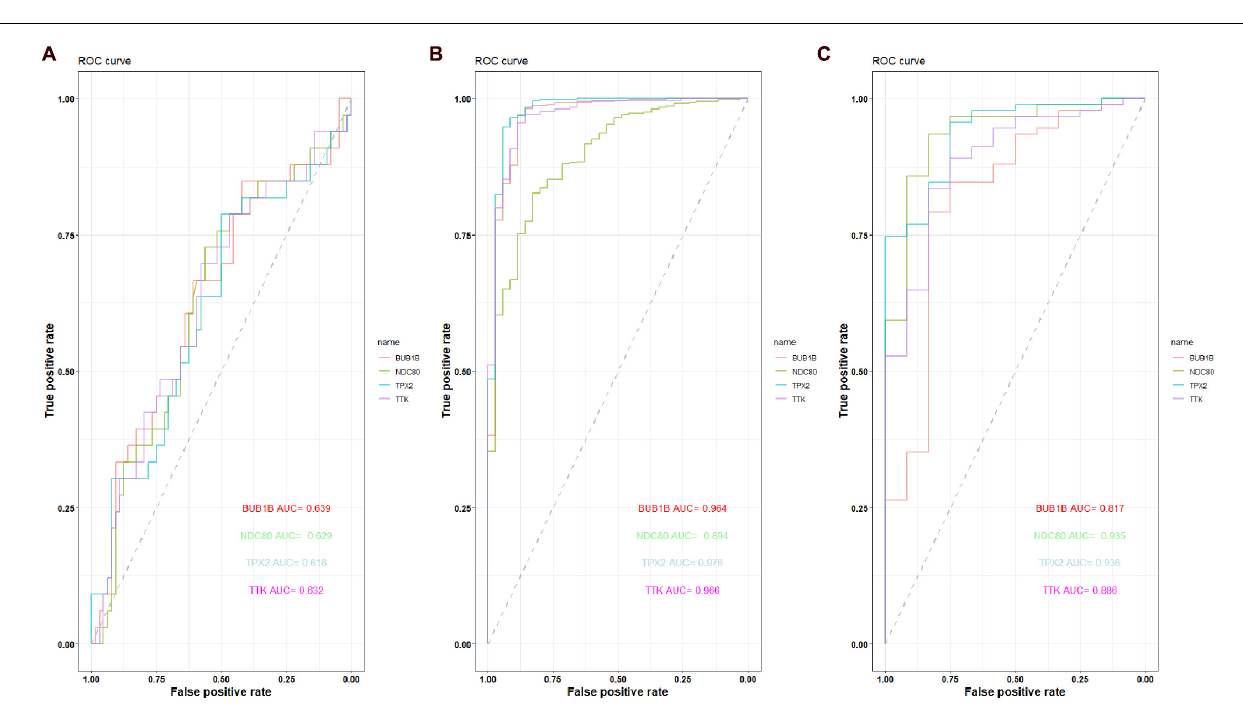
Frontiers in Genetics |